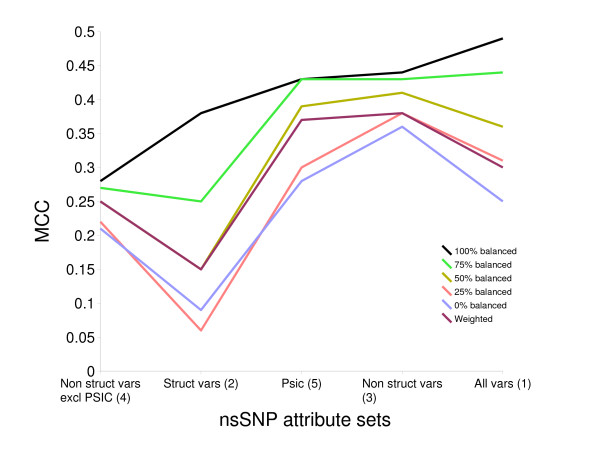
Matthews Correlation Coeffecient (MCC) measure of predictive quality for five attribute subsets. Set 1 – All variables (3821 nsSNPs). Set 2 – Structurally dependant variables (3821 nsSNPs). Set 3 – All non structurally dependant attributes (14.636 nsSNPs). Set 4 – Non structurally dependant variables excluding the conservation score (14.636 nsSNPs). Set 5 – The conservation score alone (14.636 nsSNPs).